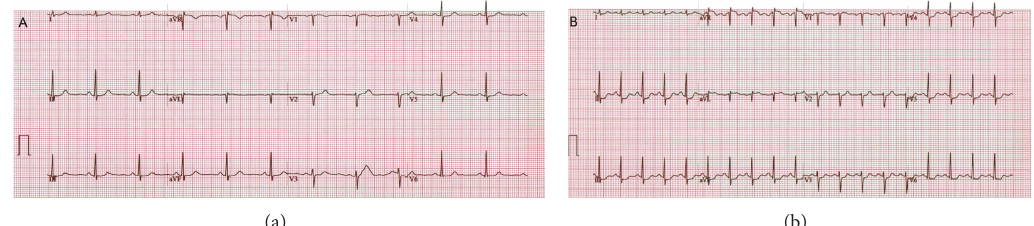
Figure 1: Resting (a) and stress (b) EKG tracings on patient undergoing regadenoson SPECT exam while taking chronic conjugated estrogen therapy. With pharmacologic stress, the patient developed 1.5 mm ST depression in the inferolateral distribution at a heart rate change of 50 (resting heart rate 61, peak stress heart rate 116, Δ ST/ Δ HR = 2).